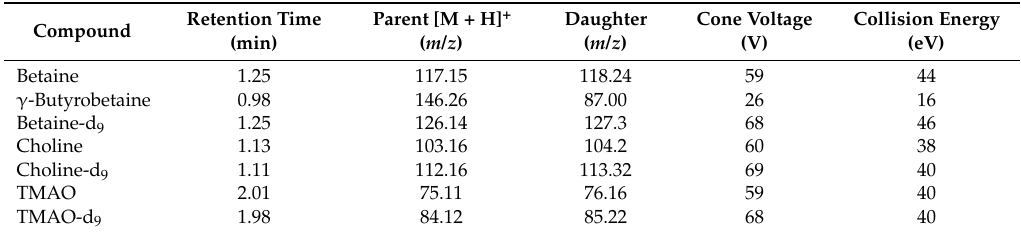
Table 1. Multi-reaction monitoring settings for isocratic ultraperformance liquid